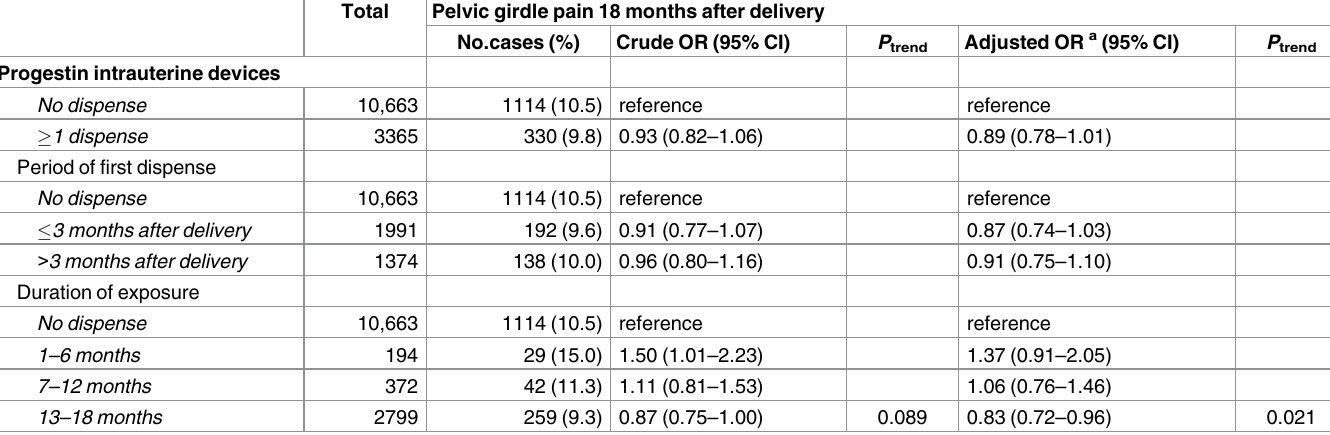
Table 3. Associations of progestin intrauterine devices and pelvic girdle pain 18 months after delivery (N = 14,028).